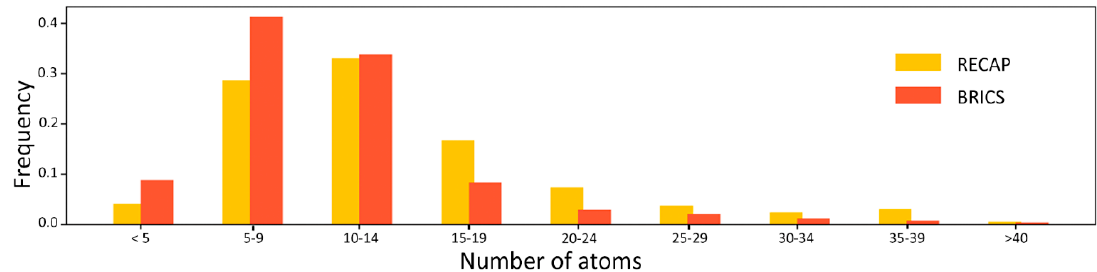
Figure 1. Distribution of the size of the fragments generated by RECAP (yellow bars) and BRICS (orange bars).